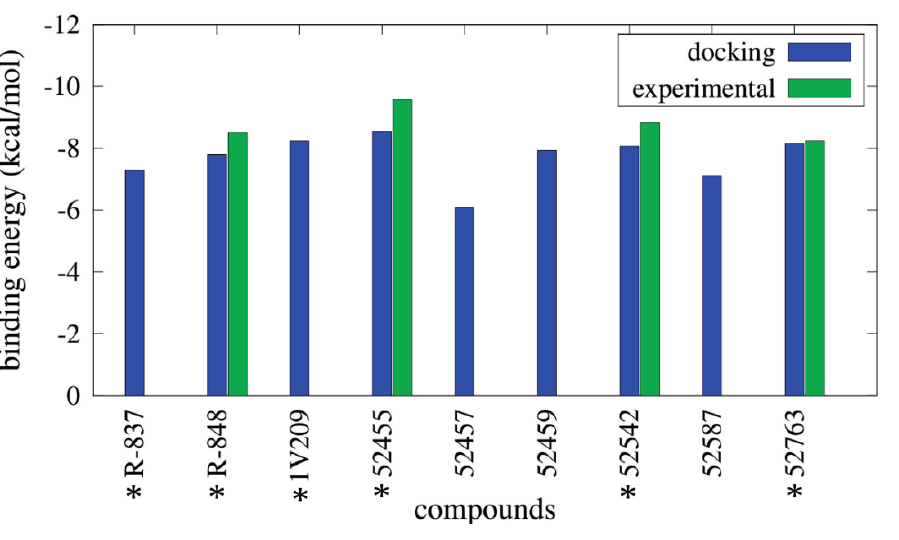
Figure 2. Binding energies for the best conformations obtained from docking simulations performed with Autodock. Computational binding energies (in blue) are compared with the available experimental binding energies (in green), calculated as RTlnEC 50 . * indicates the TLR7 agonists.